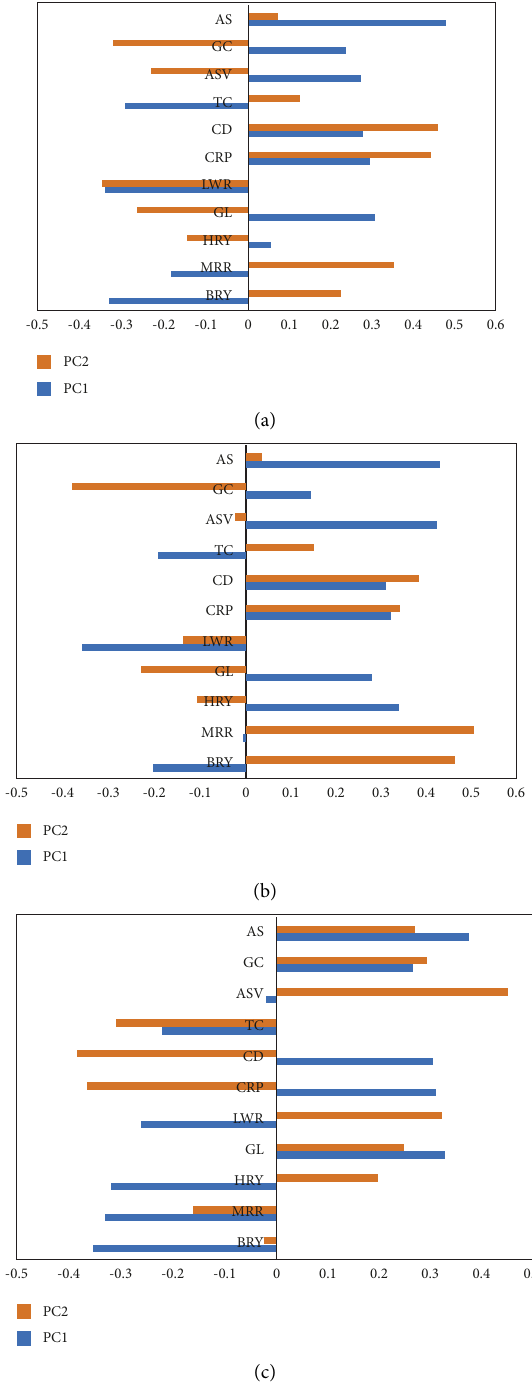
Figure 3: Te load values of PCA for the regional quality of rice. (a) Ten years; (b) the frst fve years; (c) the latter fve